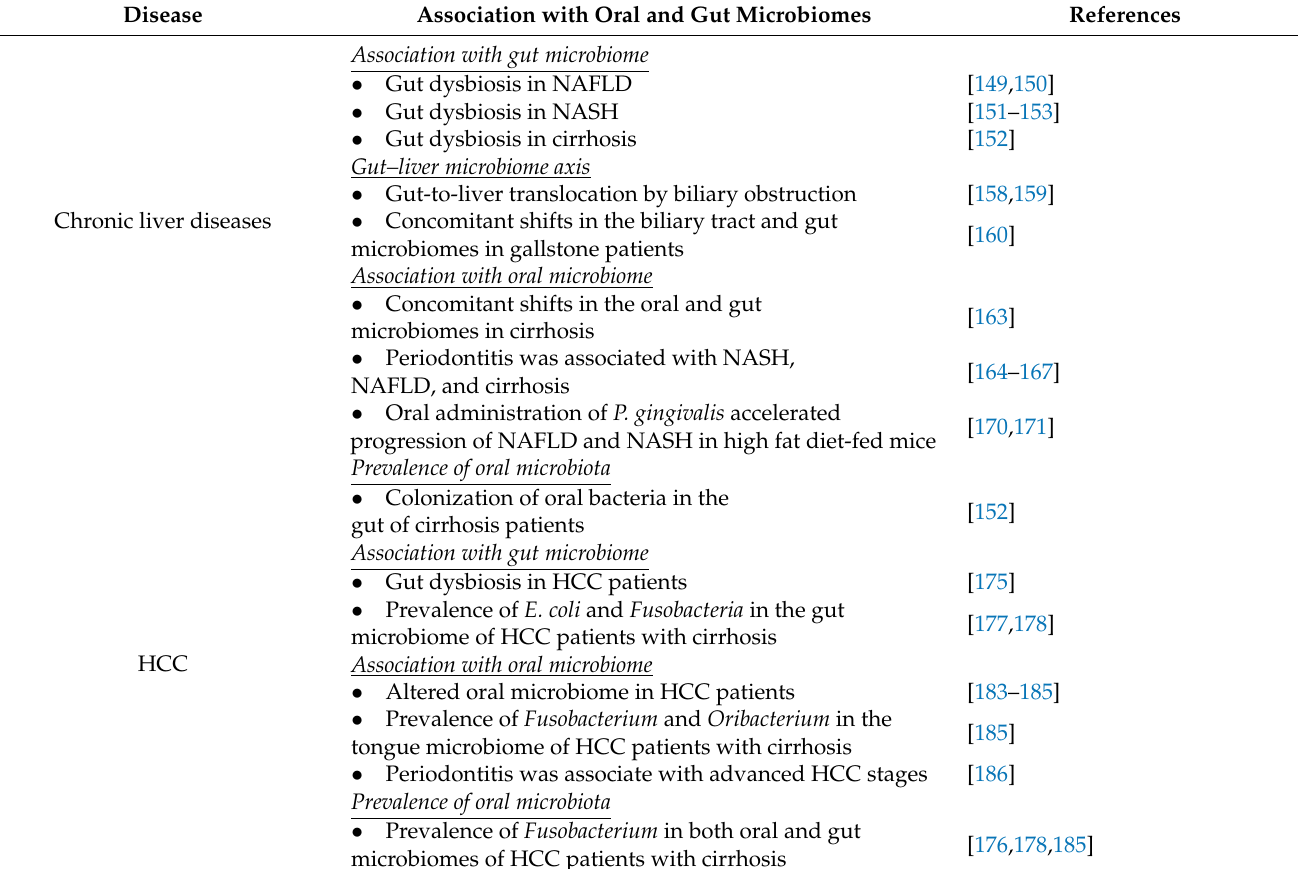
Table 2. Oral–gut microbiome axis in liver diseases.